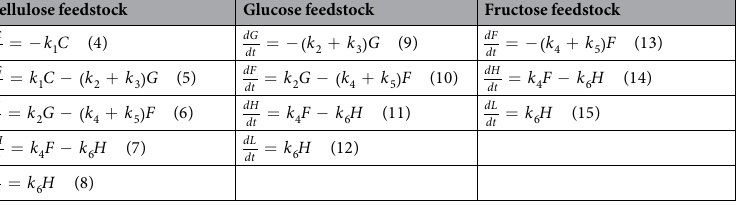
Table 1. Overview of rate equations involved in the conversion of cellulose, D-glucose, D-fructose to HMF (with C, G, F, H and L representing cellulose, glucose, fructose, HMF and levulinic acid concentration, respectively, and k 1 , k 2 , k 3 , k 4 , k 5 , k 6 (h − 1 ) are the first order reaction rate